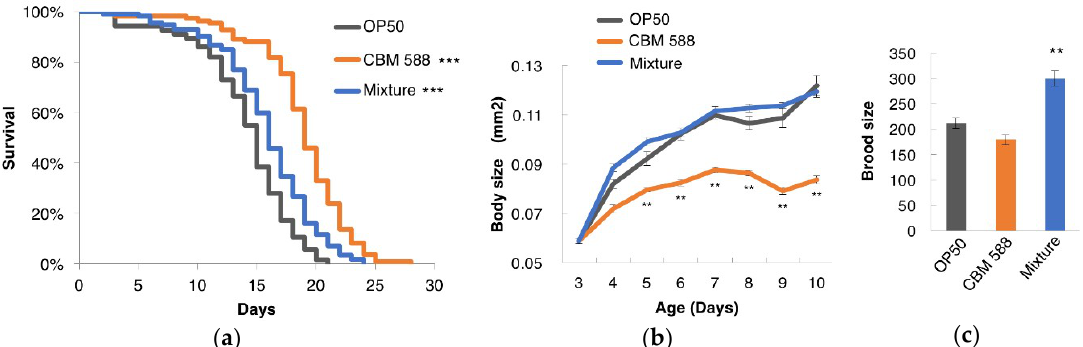
Figure 1. Clostridium butyricum MIYAIRI 588 (CBM 588) extended the lifespan of C. elegans . Survival curves ( a ), growth curves ( b ) and brood size ( c ) of animals fed OP50 (control), CBM 588, or a mixture of OP50 and CBM 588. ( a ) Worms were 3 days old on the nominal Day 0. OP50 (control)-fed group, n = 122; CBM 588-fed group, n = 109; mixture-fed group, n = 112. Differences in survival were analyzed using the log-rank test. *** p < 0.001 vs. control-fed group. Detailed lifespan data and statistics are